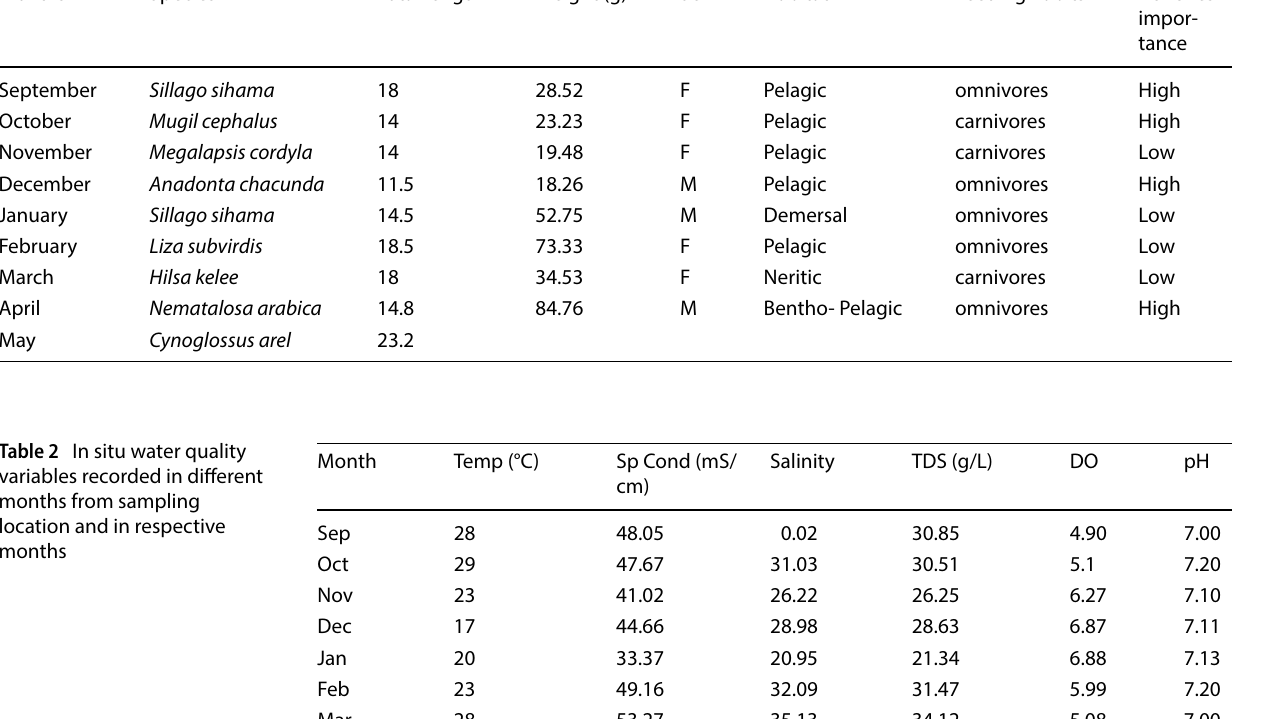
Table 1 Summary of the ecologically and economically important fish species with basic biological data studied in this study Months